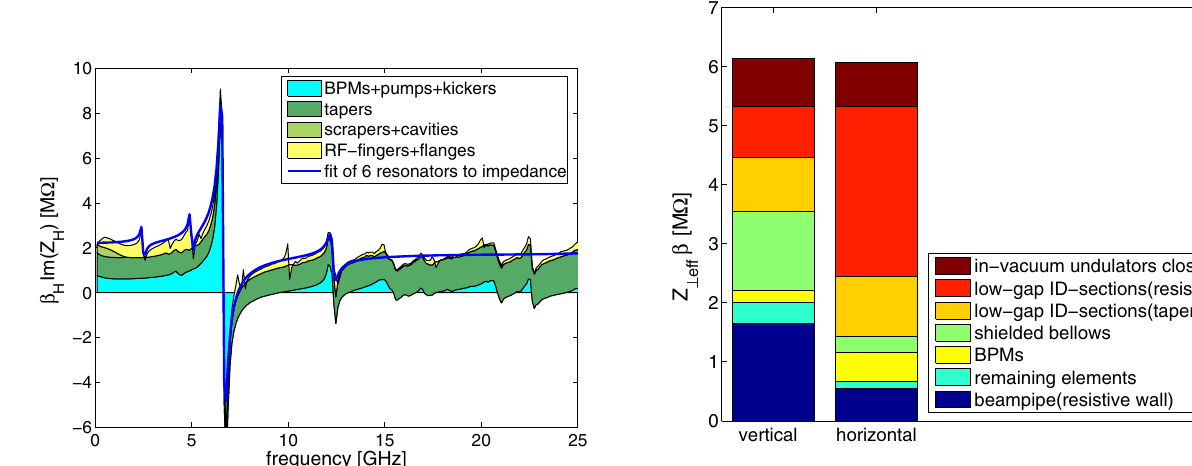
FIG. 12. (Color) Spectrum of the (cid:1) -weighted imaginary part of the horizontal impedance due to geometrical variation.